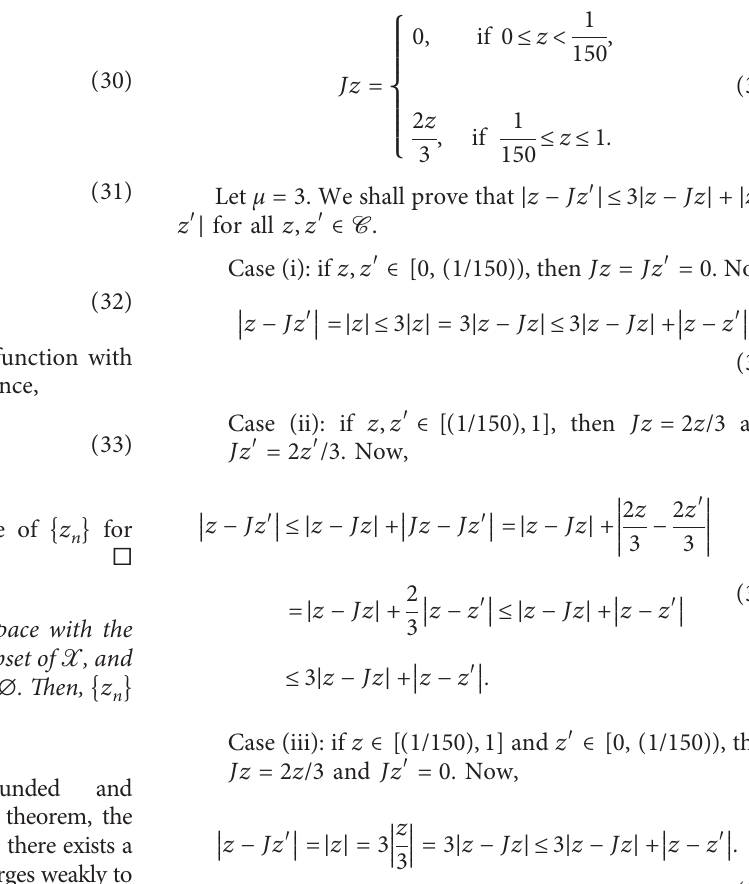
c � 0 . 90. Table 1 and Figure 1 show that the AK n